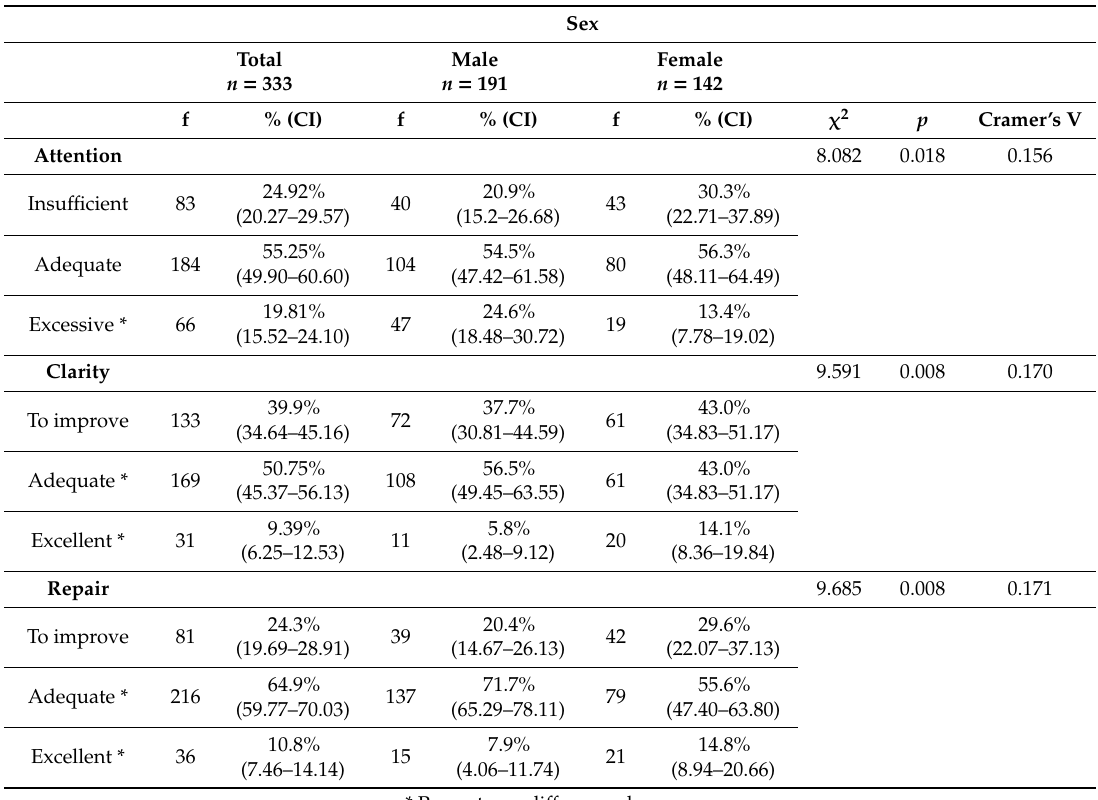
Table 2. Analysis results of the emotional Attention, Clarity, and Repair dimensions for the whole sample and according to